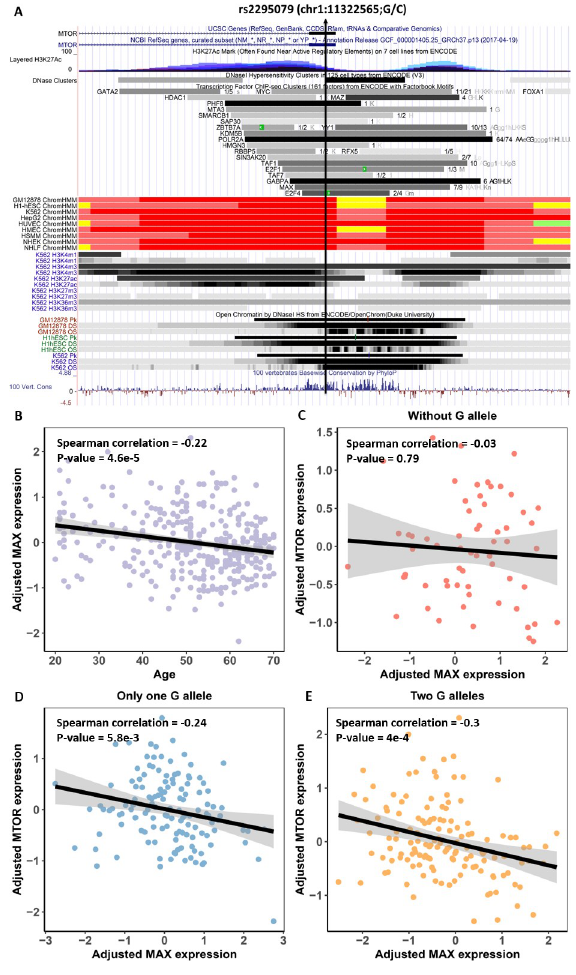
Fig 3. An example interacting TF-SNP-Gene triplet. (A) TF MAX binds to MTOR promoter region supported by DNase, H3K4me3, H3K27ac and MAX CHIP-Seq independently across several cell lines from ENCODE (K562, GM12878, and A549), and the binding is predicted to be specific to ‘G’ allele. (B) MAX gene is age-associated. (C)-(E) The correlations between adjusted MAX and MTOR expression across the three genotypes. 90%, 80%, and 70% under-sampling, average replication rates across the four tissues are 86.3%, 75% and 72.4% respectively, compared to 0% replication for background control. For the triplet detection, all under-sampled datasets on average across four tested tissues exhibit replication rate of 68%, 56%, 49% respectively for 90%, 80%, 70% sampling in contrast to 0% replication rate for the background datasets. The decreasing trend of replication rates for 90%, 80%, 70% samples is consistent with the fact that sample size determine the statistical power.